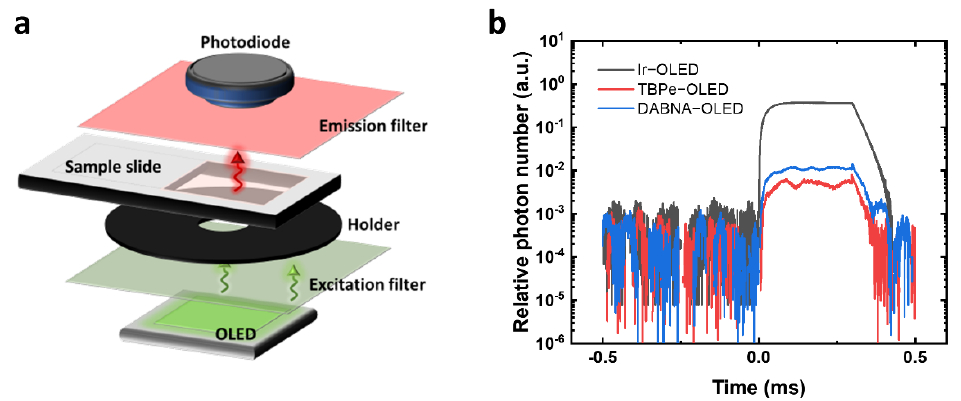
Figure 2. Fluorescence sensing setup. ( a ) Schematic diagram of the main components of the fluores- cence sensing system. ( b ) Leakage light response of different OLEDs measured by the fluorescence sensing system in pulsed operation.